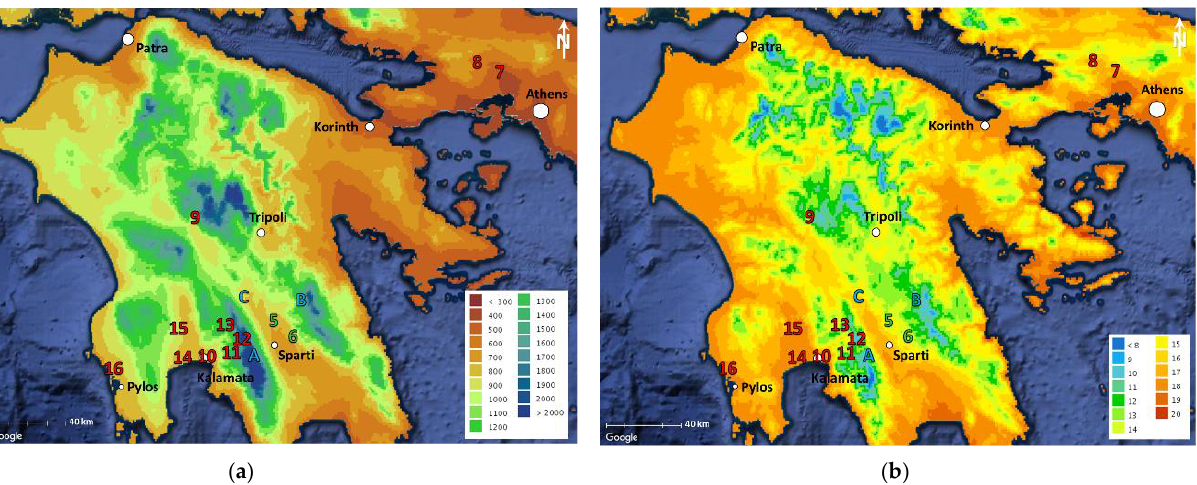
Figure A1. Climatic maps of the area of HYDRONET. Stations located in Athens basin are not shown due to scale limits. ( a ) Average annual rainfall (mm), ( b ) Average annual temperature (°C). Maps available from http://climatlas.hnms.gr/sdi/, accessed on 3 September 2022 [28] and modified by the authors.